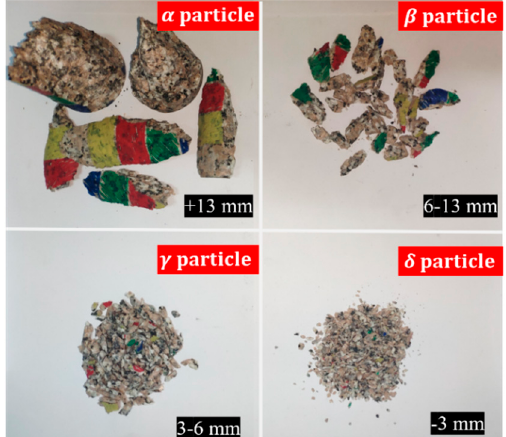
Figure 4. Classification of fragments produced by uniaxial compression.